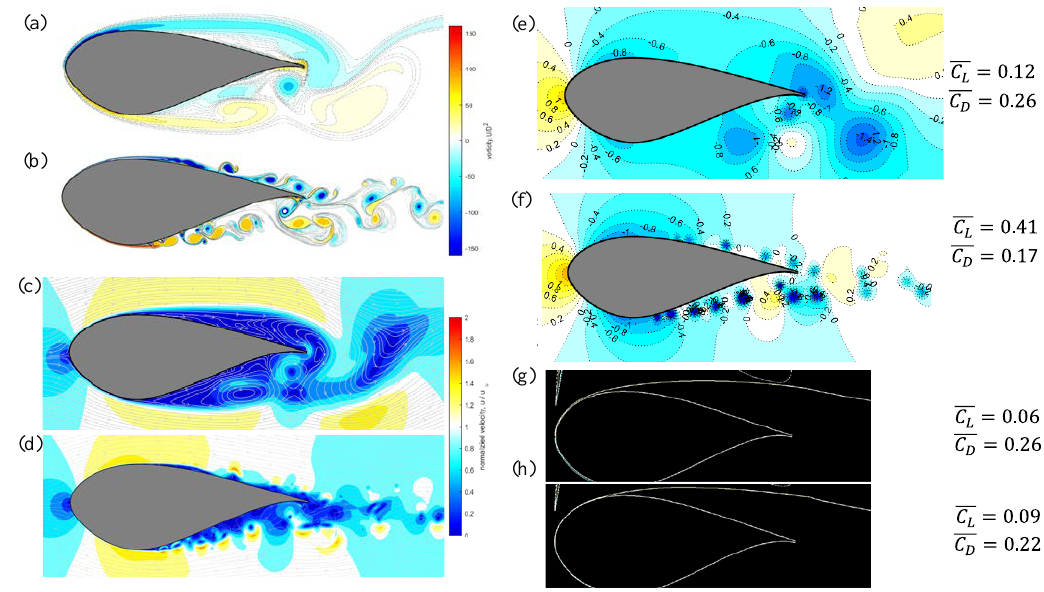
Figure 11. Instantaneous fields of DU40 airfoil at α = 0 ◦ . Vorticity: ( a ) Re C = 4000 and ( b ) Re C = 60,000. Velocity: ( c ) Re C = 4000 and ( d ) Re C = 60,000. Pressure coefficients, Cp: ( e ) Re C = 4000 and ( f ) Re C = 60,000. Steady-state simulation of boundary layer streamlines by XFOIL: ( g ) Re C = 4000 and ( h ) Re C = 60,000. Note: ( a , c , e ) correspond to the first red star in Figure 10a ( Ut / C = 53.365) while ( b , d , f ) correspond to the first red star in Figure 10b ( Ut / C = 3.396). For ( e – h ), the associated mean force coefficients are attached on the right.